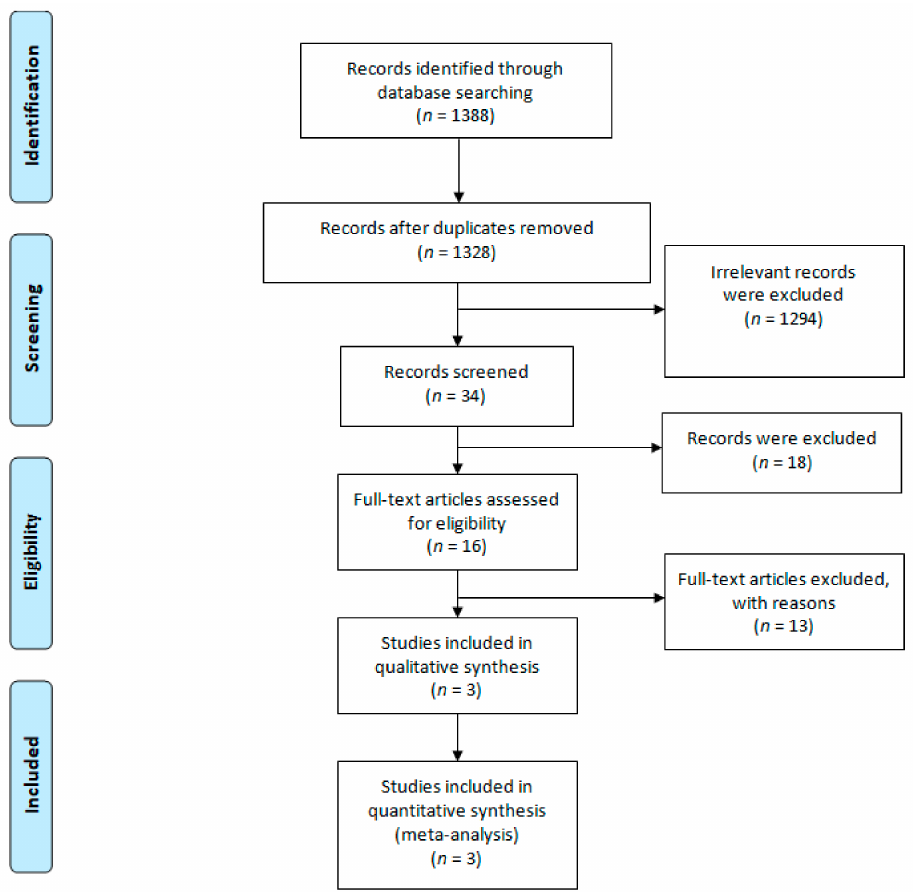
Figure 1. PRISMA flow